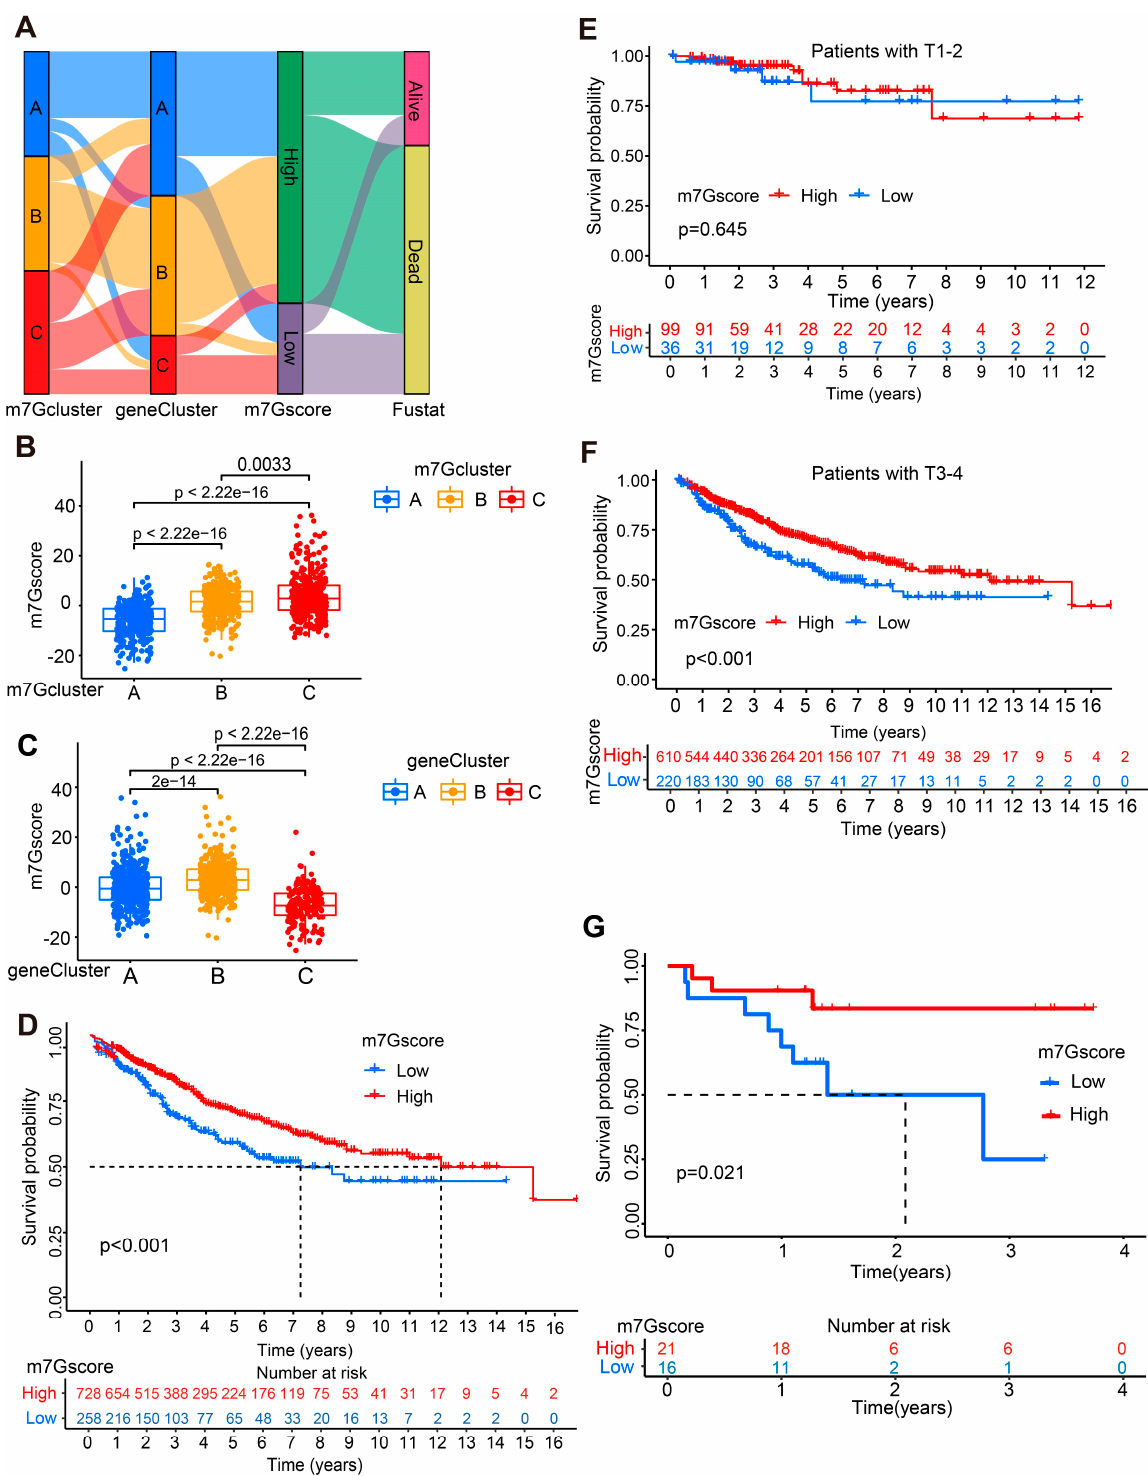
Figure 5. Construction and verification of the m7G score prognostic model. ( A ) Sankey diagram for the modeling process. ( B ) The m7G score level in CC patients from different m7G clusters. ( C ) The m7G score level in CC patients from different gene clusters. ( D ) KM curves for the OS of CC patients from high- and low-m7G score groups. ( E , F ) KM survival analysis based on m7G score in CC patients at different T stages. ( G ) KM survival curves based on m7G scores in CC patients from the GSE31595 validated cohort.